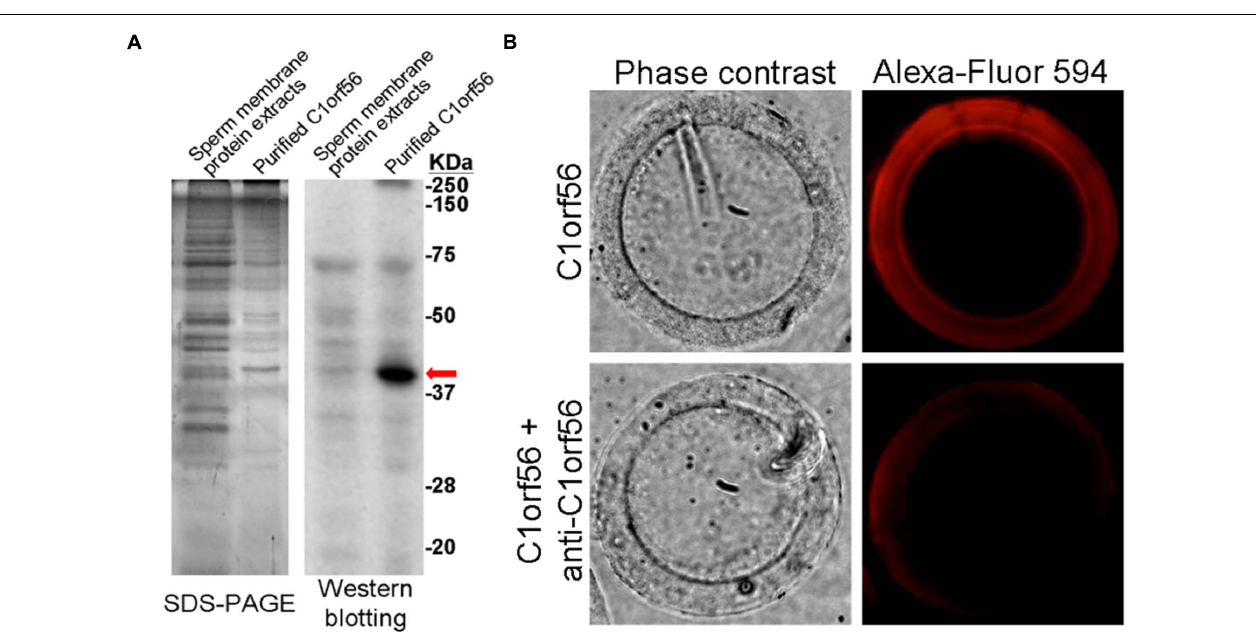
FIGURE 6 | Binding of purified C1orf56 to human ZP. (A) C1orf56 was partially purified from membrane protein extracts of capacitated spermatozoa by anti-C1orf56 immuno-affinity chromatography. The purity of the purified proteins (arrow) was checked by SDS-PAGE and Western blotting. (B) Purified C1orf56 was labeled with Alexa Fluor-594 labeling kit (Invitrogen). Matching hemizona were incubated with the 1 µ g/mL labeled C1orf56 in the presence or absence of polyclonal anti-C1orf56 neutralizing antibody. The results shown are representative of three replicate